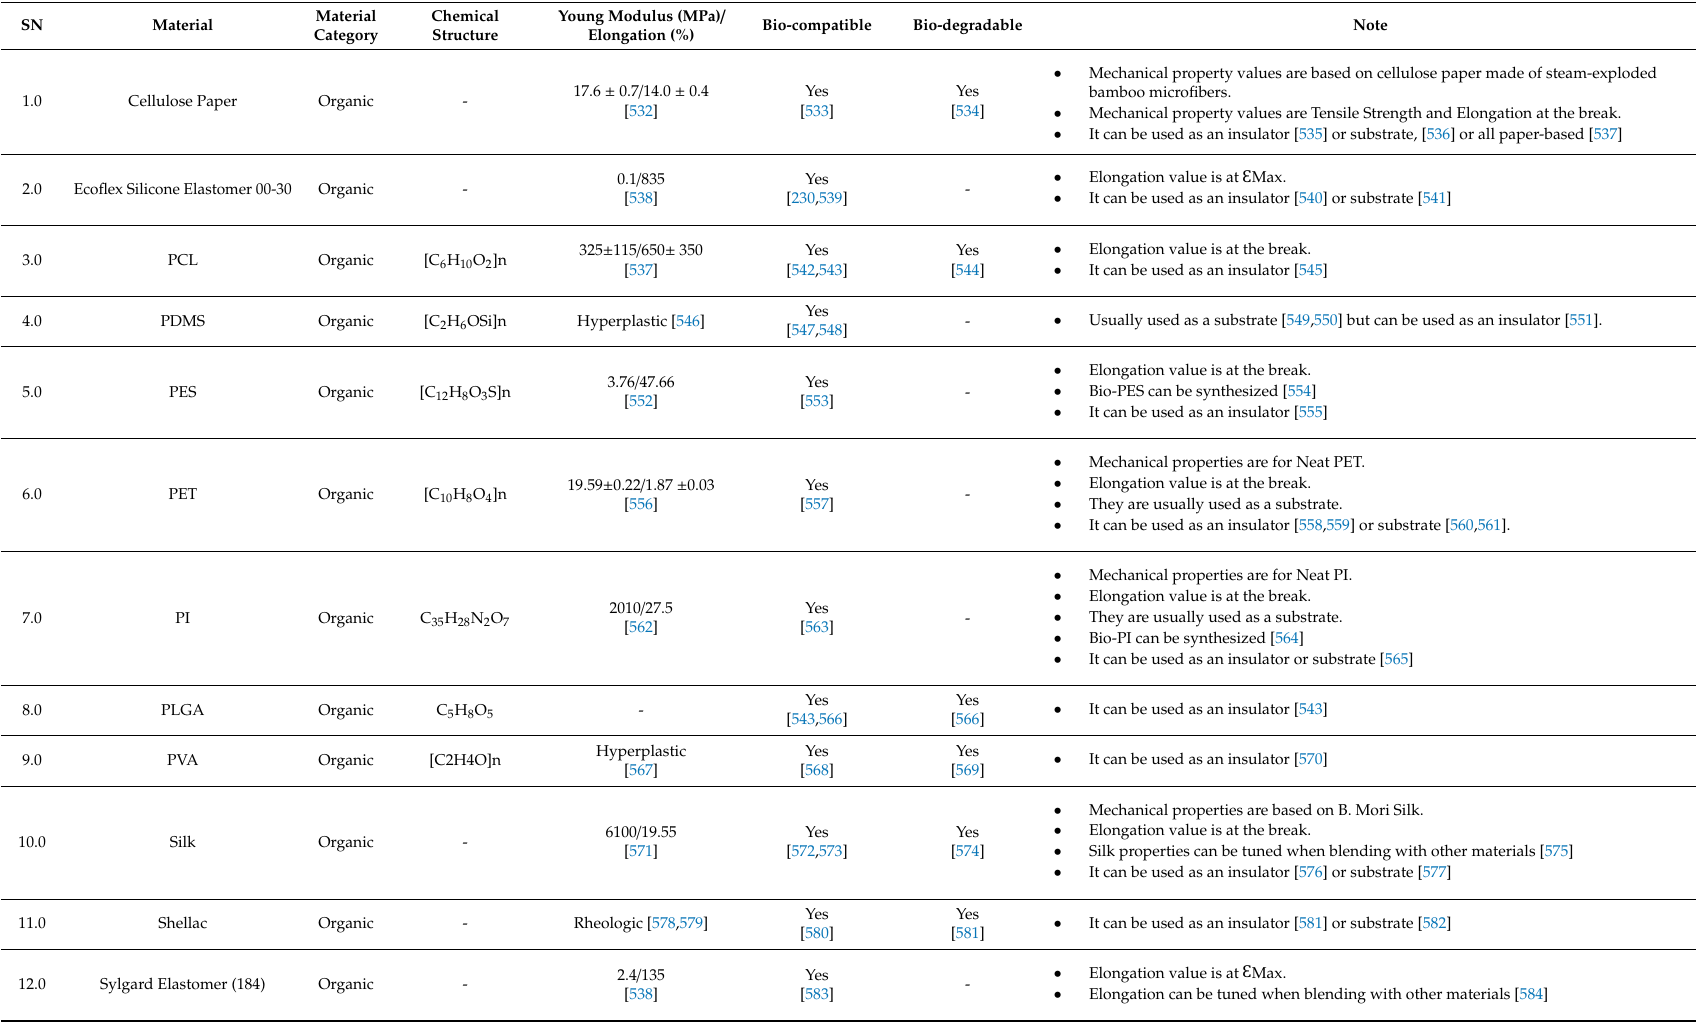
Table 6. List of biocompatible and biodegradable materials used in wearable sensors as substrates and / or